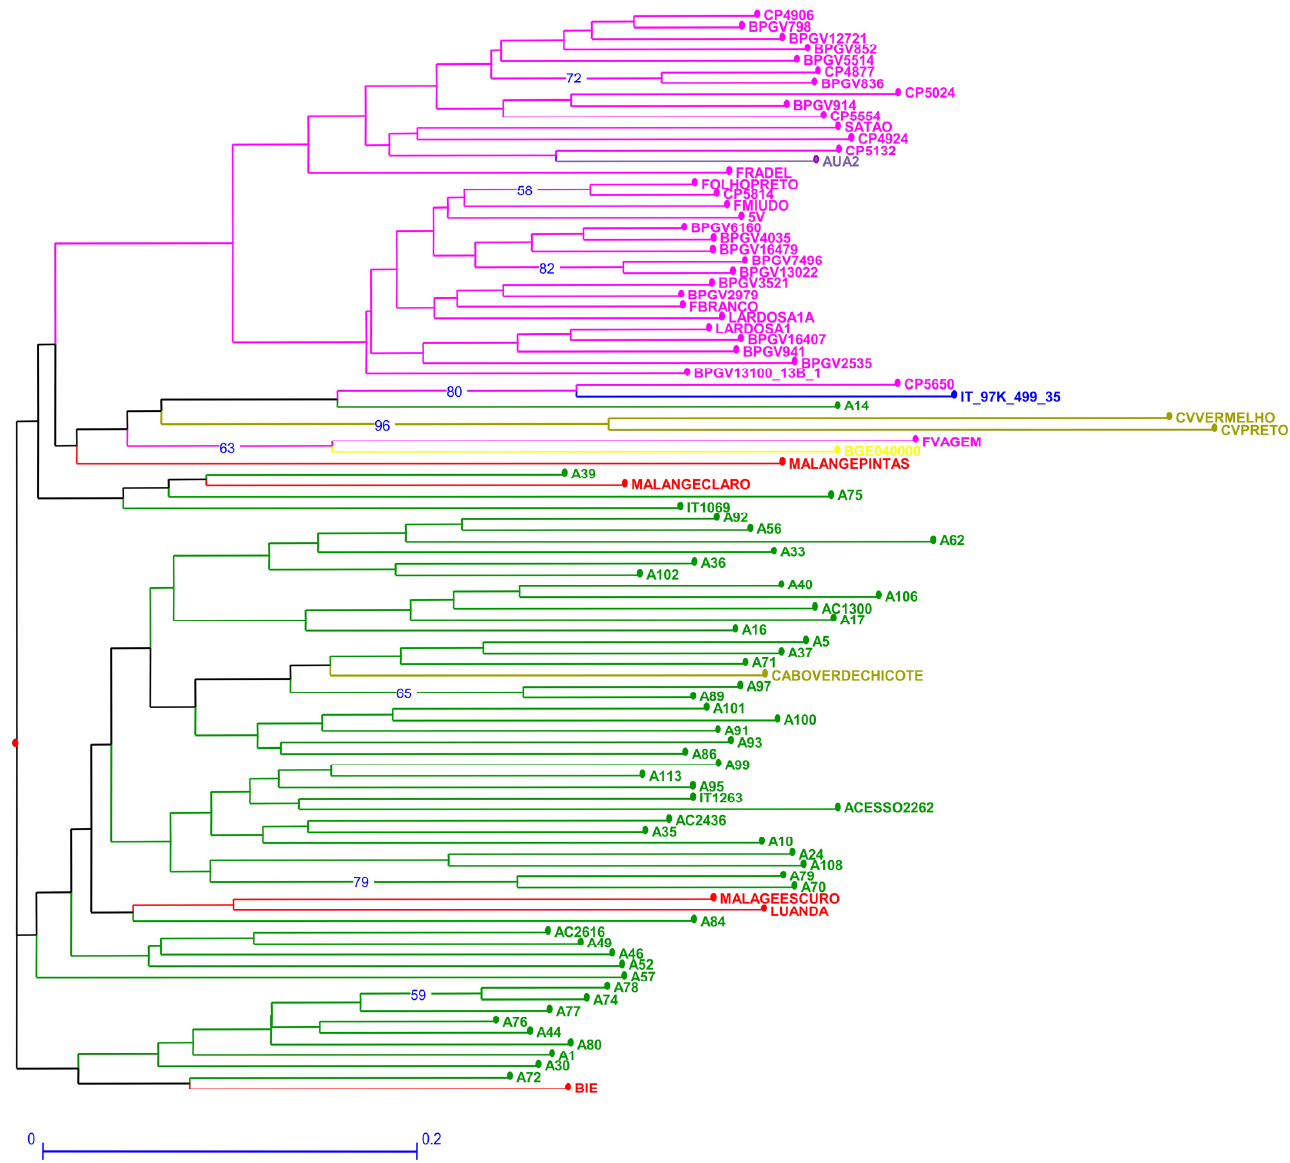
Figure 2. Neighbor joining dendrogram of cowpea genotypes, identified by the twelve SSR markers. Numbers associated with branches indicate bootstrap values (BS) based on 20,000 replications. Only BS values above 50 are shown. Branch lines represent individual accessions grouped by country (red: Angola, olive green: Cape Verde; yellow: Spain; purple: Greece; green: Mozambique; blue: Nigeria and pink: